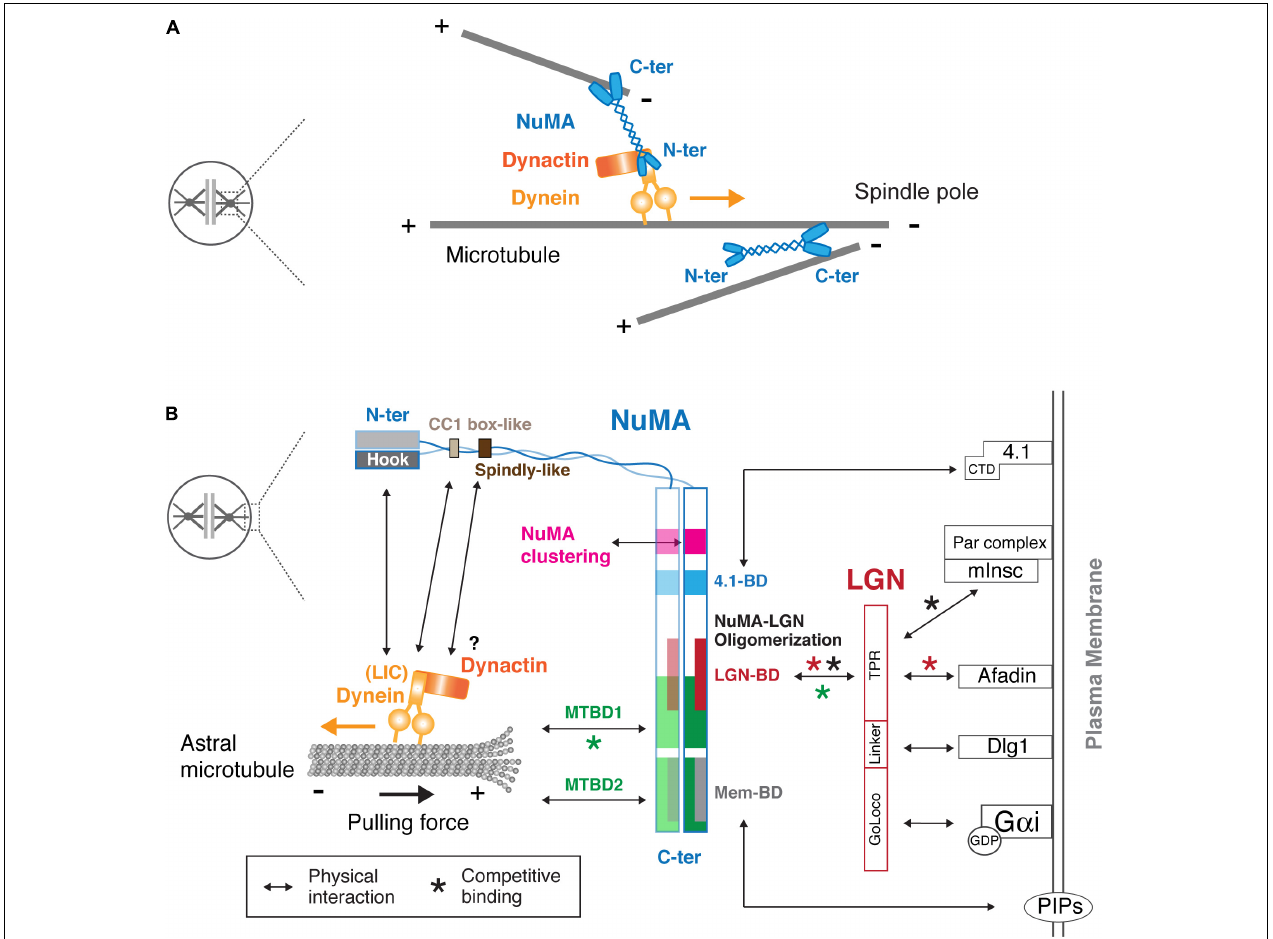
FIGURE 3 | Physical interaction map of NuMA at the spindle pole and the mitotic cell cortex. (A) Models of the spindle pole focusing function of NuMA. Using two microtubule-binding C-terminal globular domains, the NuMA homodimer bundles and crosslinks microtubules around the spindle pole region (Radulescu and Cleveland, 2010; Forth et al., 2014). In addition, NuMA recognizes the minus-ends of spindle microtubules and recruits the dynein-dynactin complex, which transports NuMA-bound spindle microtubules toward poles, resulting in microtubule focusing at the poles (Hueschen et al., 2017). See text for details. (B) NuMA interacts with the cortical proteins and plasma membrane through its C-terminal region, whereas it binds to dynein and dynactin via its N-terminal region. Arrows indicate physical interactions. As indicated by red asterisks, NuMA competes with Afadin for LGN binding. In addition, NuMA competes with mInsc for LGN binding during asymmetric cell division (black asterisks). The MTBD1 overlaps LGN–BD, and thus LGN binding to NuMA inhibits the microtubule binding activity of MTBD1 (green asterisks). LGN consists of TPR, Linker and GoLoco motifs, and each motif interacts with Afadin (Carminati et al., 2016), Dlg1 (Saadaoui et al., 2014), and the GDP-bound form of G α i (Jia et al., 2012), respectively. NuMA/LGN/G α i constitutes a conserved core pathway for cortical dynein recruitment. The C-terminal domain (CTD) of band 4.1 proteins interacts with the NuMA C-terminal domain, and is sufficient to rescue cortical NuMA enrichment in anaphase in LGN and 4.1 co-depleted cells (Kiyomitsu and Cheeseman, 2013). See text for